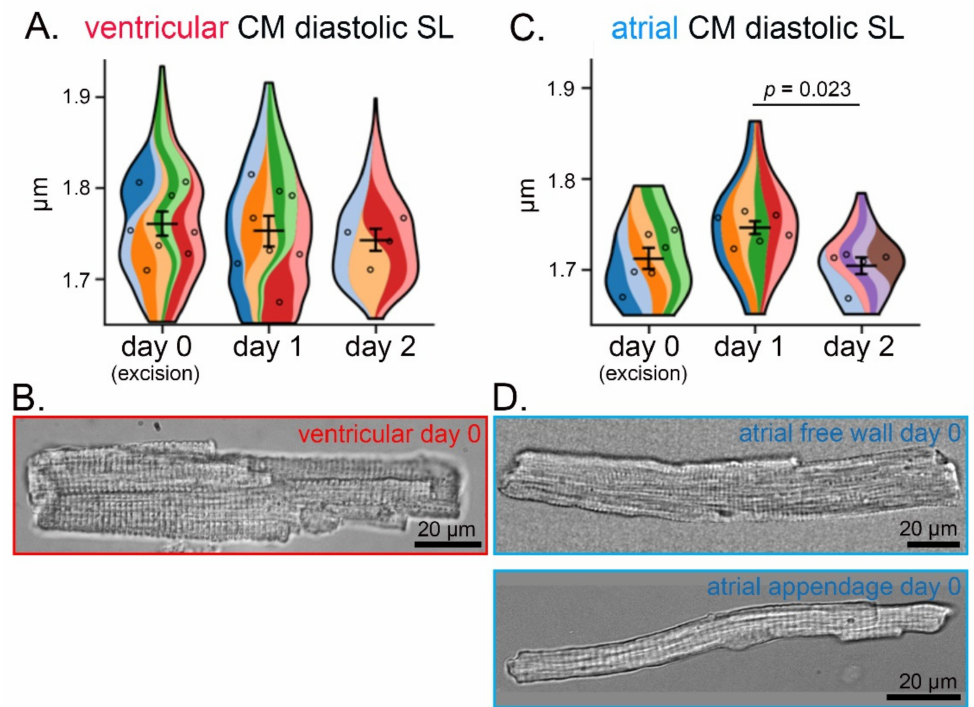
Figure 3. Ventricular and atrial CM morphology does not show statistically significant differences over three consecutive days of cell isolation from cardiac tissue slices from the same rabbit heart. ( A ) Diastolic SL of isolated ventricular CM over three consecutive days of isolation; n = 4–8 hearts, 150–300 CM/day of isolation. ( B ) Representative phase-contrast microscopy image of living ventric- ular CM after isolation. ( C ) Diastolic SL of isolated atrial (free wall and appendage combined) CM over three consecutive days of isolation; n = 5–6 hearts, 40–140 CM/day of isolation. ( D ) Representa- tive brightfield microscopy image of living atrial free wall ( top ) and appendage ( bottom ) CM after isolation. ( A , C ) each color represents data from one heart. Within each colored area, the open circles represent the average of all cells recorded from the same